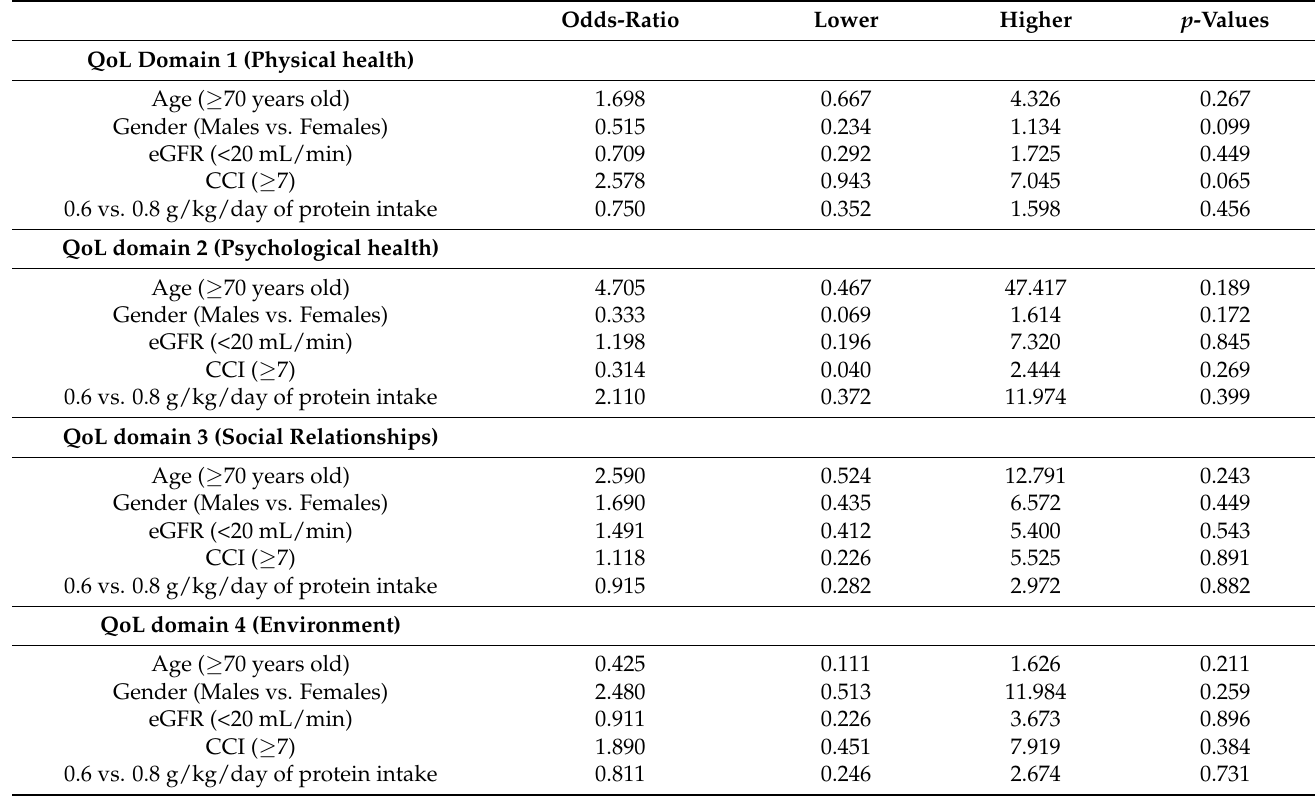
Table 5. Multiple logistical regression for the outcome poor quality of life in the UIRAV cohort. Odds-Ratio Lower Higher p